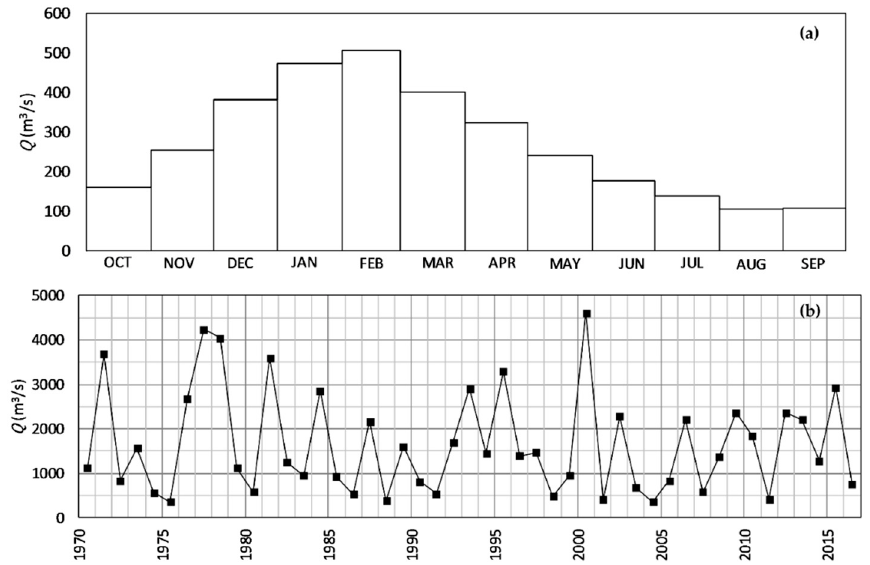
Figure 2. Seasonal behaviour of the Minho river flow. ( a ) Monthly averaged flow rate; and ( b ) annual maximum river flow rate. Table 3. Return periods and river